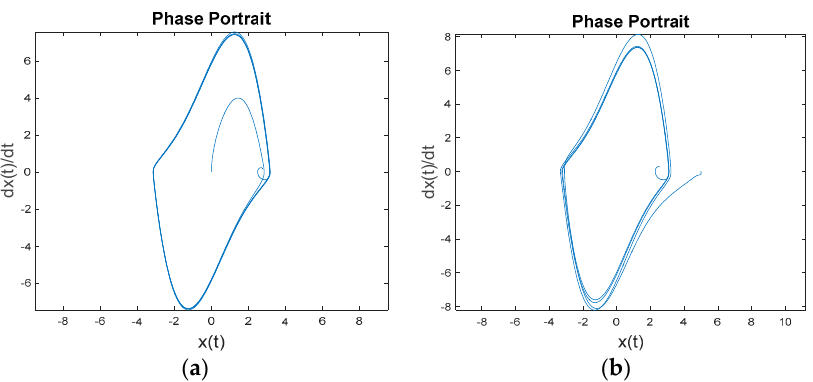
Figure 5. Commanding a desired trajectory as a circle of radius five using optimal linear, time-invariant feedback control: ( a ) displays trajectory comparison; and ( b ) trajectory.